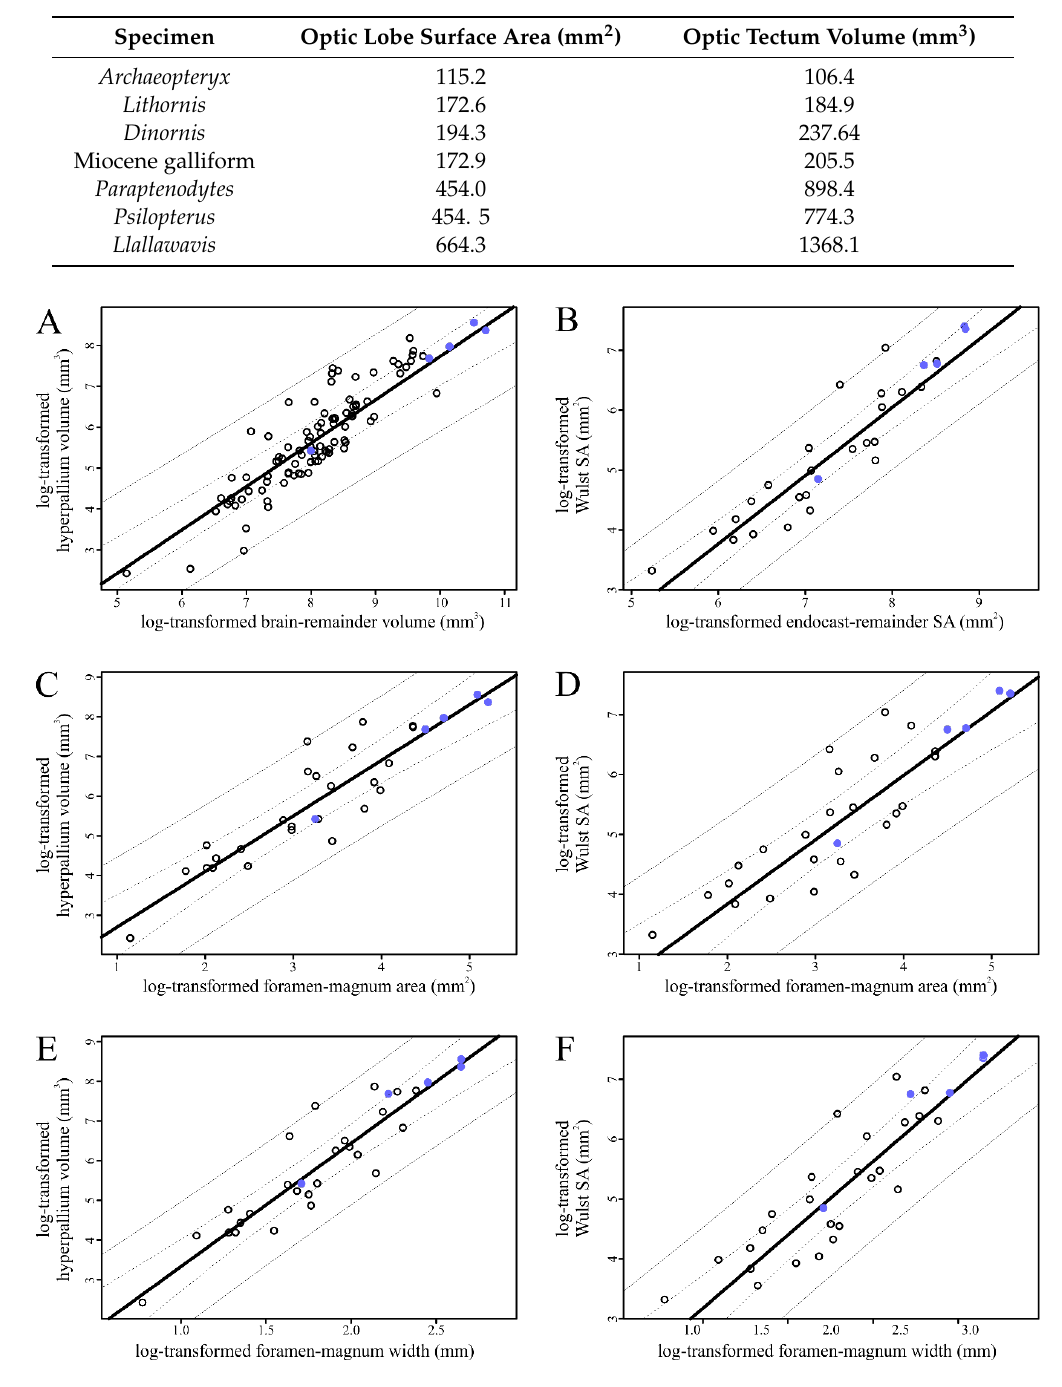
Figure 4. Scatterplots of hyperpallium metrics. All values are log-transformed, and on each plot, the solid line represents a phylogenetic generalized least squares (PGLS) regression from the extant sample, the dotted lines represent confidence intervals, and the dashed lines represent prediction intervals. The open points represent extant taxa. The values for the extinct sample are plotted as blue points. ( A ) Hyperpallium volume regressed on brain-remainder volume. ( B ) Wulst surface area regressed on endocast-remainder surface area. ( C ) Hyperpallium volume regressed on foramen-magnum area. ( D ) Wulst surface area regressed on foramen-magnum area. ( E ) Hyperpallium volume regressed on foramen-magnum width. ( F ) Wulst surface area regressed on foramen-magnum width. Table 4. Measured optic-lobe surface areas and phylogenetically predicted optic-tectum volumes for all extinct species in the sample.